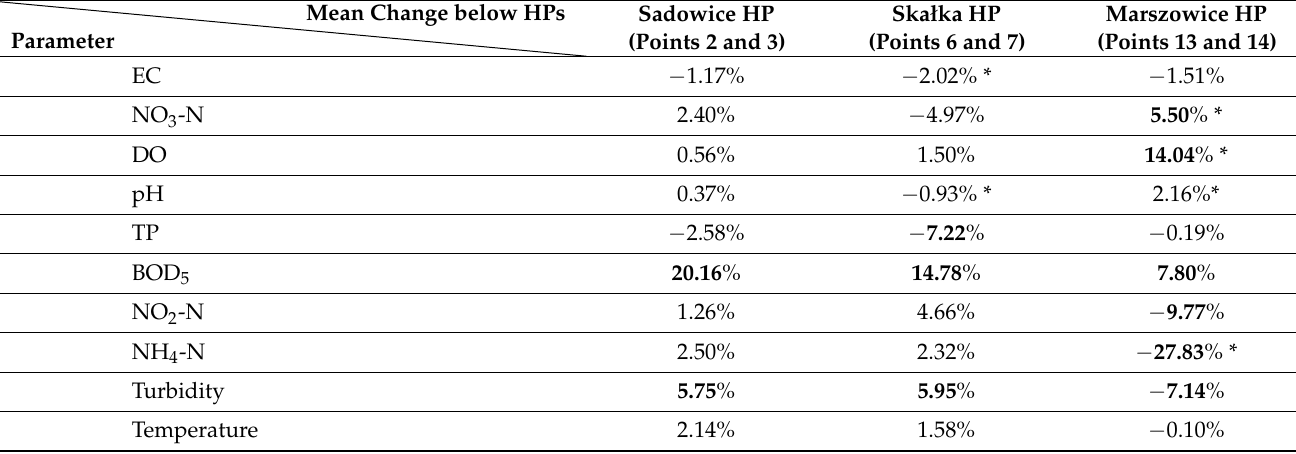
Table 6. Average percentage change in physicochemical parameters below the Sadowice, Skałka, and Marszowice hydropower